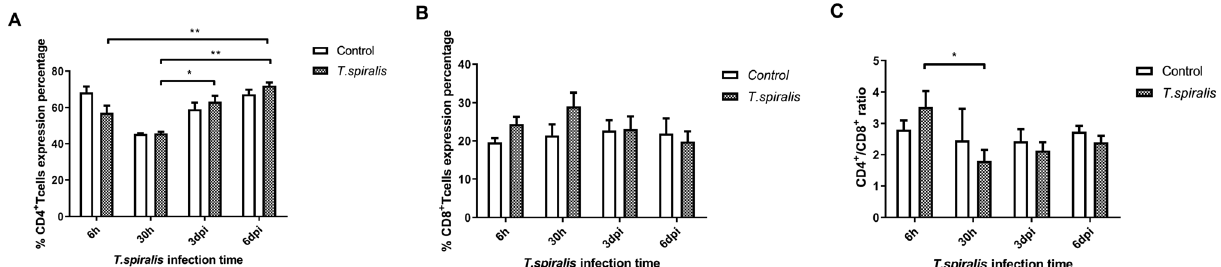
Figure 3. Percentage and expression levels of CD4+ and CD8+ T cells in mice infected with 250 muscle larvae of Trichinella spiralis compared to uninfected (control) mice from 6 h to 6 dpi. (A) Comparison of the mean percentage (±SD) of CD4 + T cells. (B) Comparison of the mean percentage (±SD) of CD8 + T cells. (C) Comparison of the expression (±SD) of CD4 + /CD8 + T cells. * p < 0.05 and ** p < 0.01 indicating a statistically signi fi cant difference.